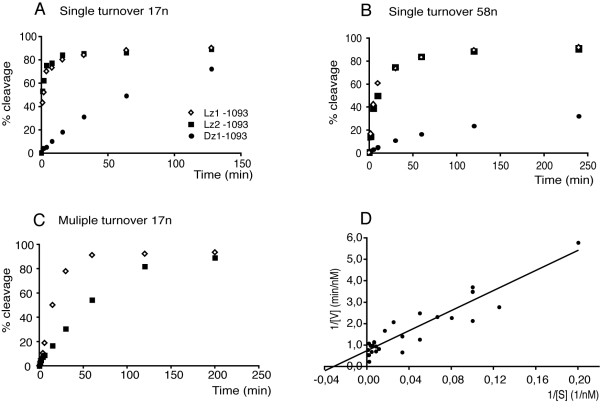
Kinetics of cleavage at the 1093-site by LNAzymes. (A) Single turnover cleavage of 17n by Dz1-1093 (circles), Lz1-1093 (squares) and Lz2-1093 (diamonds). The enzymes are in 5 × excess. (B) Single turnover cleavage of 58n by Dz1-1093 (in 50 × excess), Lz2-1093 (in 5 × excess), and Lz2-1093 (in 5 × excess). (C) Multiple turnover cleavage of 17n by Lz1-1093 and Lz2-1093. (D) Lineweaver-Burk plot showing Lz1-1093 data points obtained over a full range of substrate concentrations (5 nM to 1.2 μM), and used for determination of Km and Vmax.